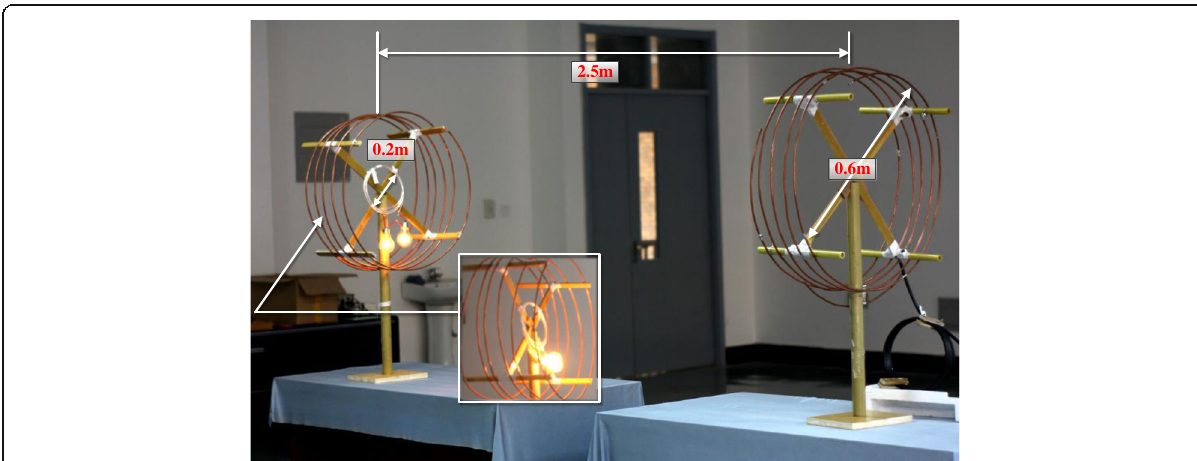
Fig. 7 Wireless power transfer to two 60-W bulbs under interval of 2.5 m. The distance between the transmitting coil and the receiving coil is 2.5 m. The receiving end power through the coupling of up to 120 W and successfully lit the two